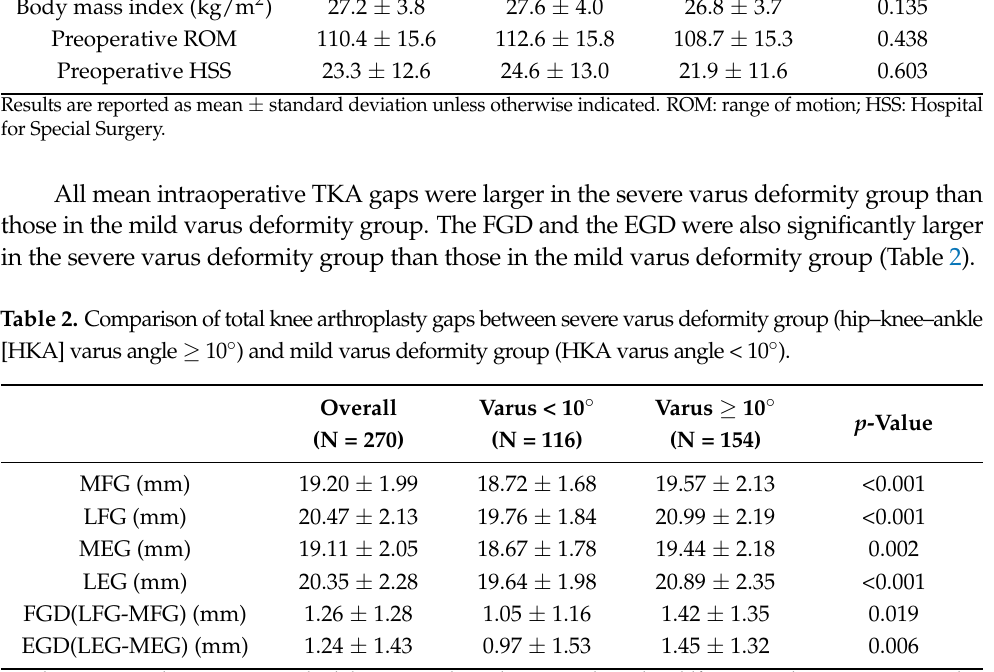
Table 3. Radiologic measurement parameters in the severe varus deformity group (hip–knee–ankle [HKA] varus angle ≥ 10 ◦ ) and mild varus deformity group (HKA varus angle < 10 ◦ ). Overall Varus < 10 ◦ Varus ≥ 10 ◦ (N = 270)